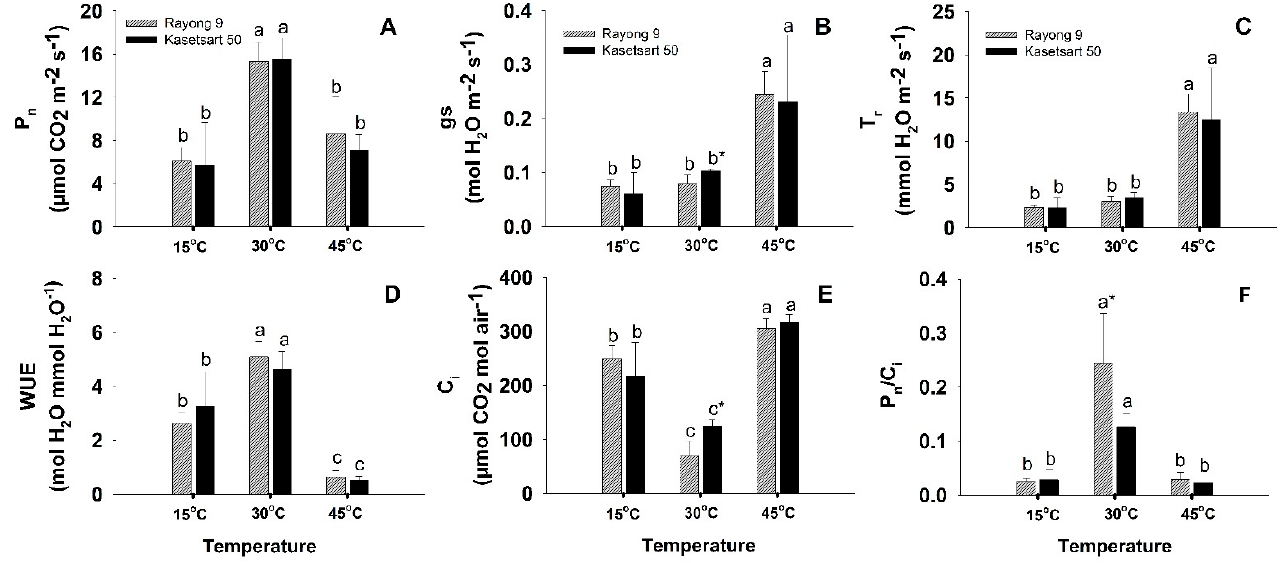
Figure 1. The effects of short-term exposure to different temperatures (15, 30, and 45 ◦ C) on photosynthetic parameters including net photosynthesis (P n ) ( A ), stomatal conductance (gs) ( B ), transpiration rate (T r ) ( C ), water use efficiency (WUE) ( D ), intercellular CO 2 concentration (C i ) ( E ), and ratio between P n and C i , and ( F ) of cassava cvs. Rayong 9 and Kasetsart 50. Means (±SD) which are significantly different ( p < 0.05) among treatments for each cultivar are denoted by different lower-case letters. The significant differences between cassava genotypes are denoted with *.